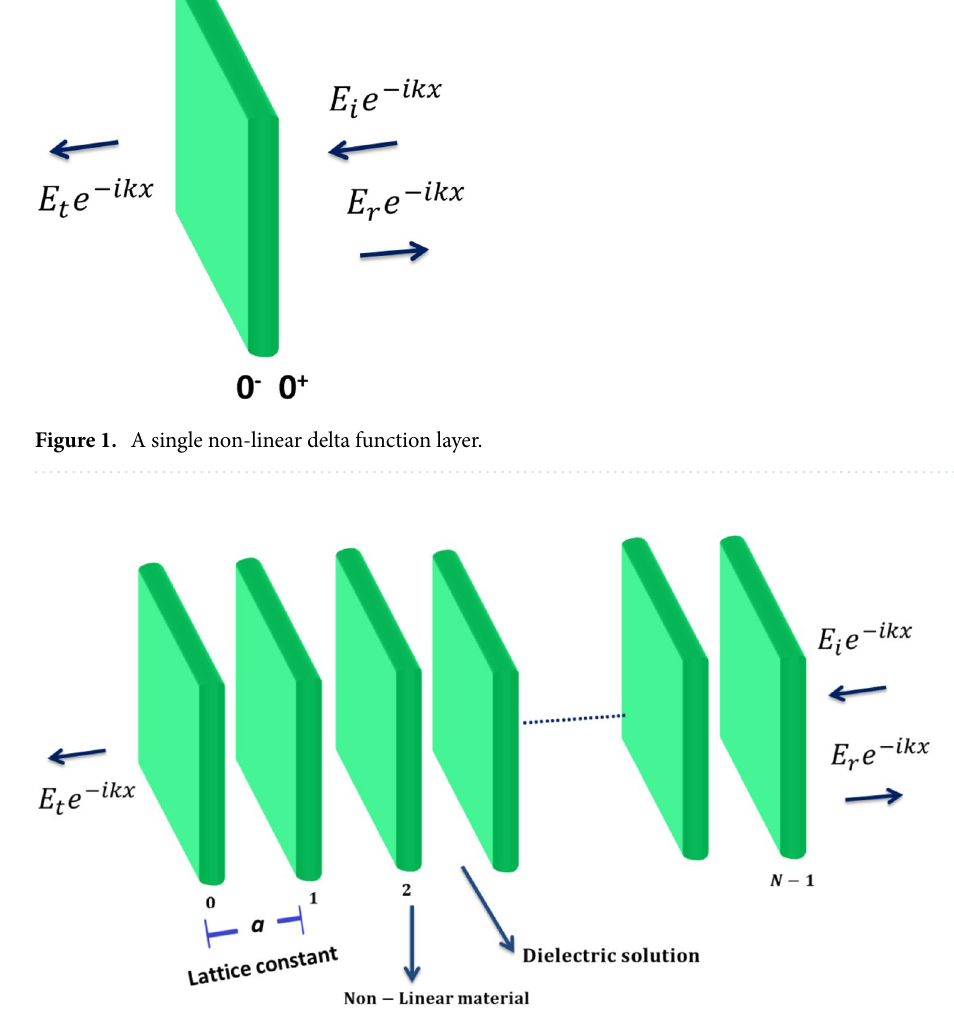
Figure 2. Immersion of a 1D priodic Kronig–Penny non-linear δ-function PC in an aqueous